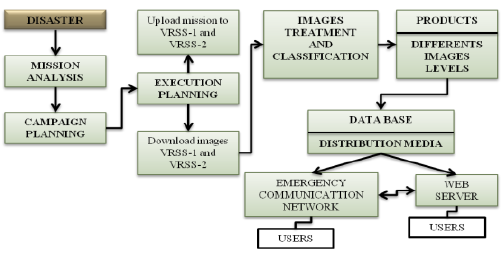
Figure 8. VRSS-1 and VRSS-2 images management and processing in emergency 2.5 VENESAT-1 Transponders and Radiofrequency